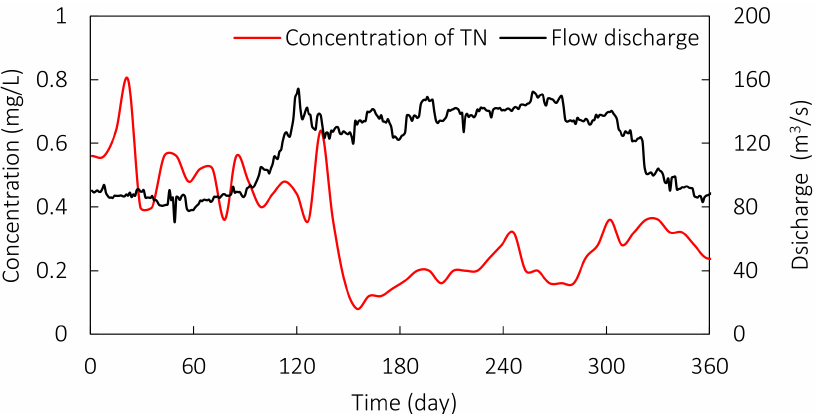
Figure 5. Flow discharge and concentration of TN at the inlet of the middle